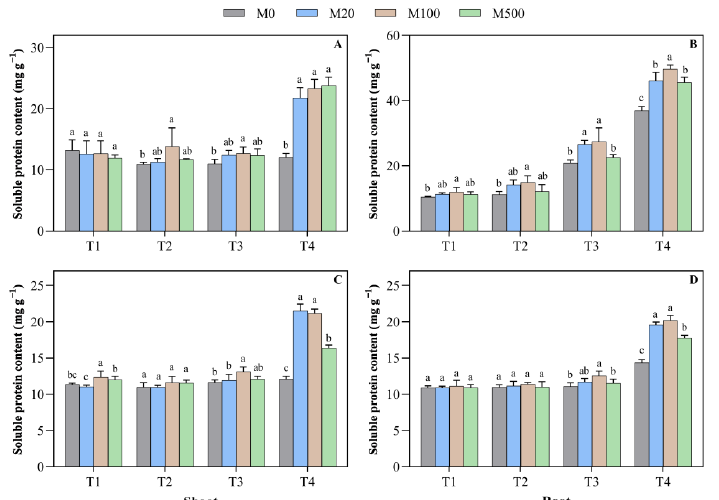
Figure 8. Effects of exogenous melatonin on the soluble protein content in rice seed germination under high temperature stress. Means ± SEs with different letters in each parameter indicate significant statistical differences ( p < 0.05). ( A ) Soluble protein content of the shoot (7 d); ( B ) soluble protein content of the root (7 d); ( C ) soluble protein content of the shoot (9 d); and ( D ) soluble protein content of the root (9 d).